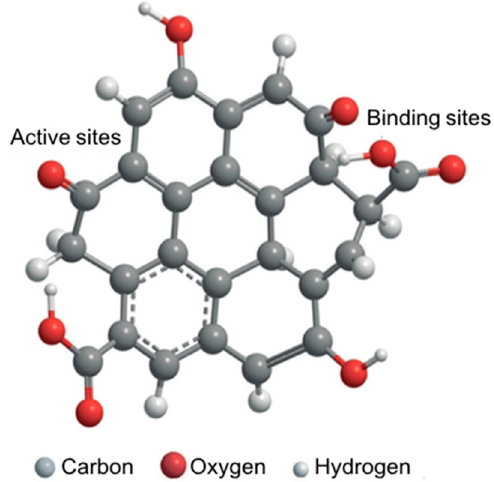
Figure 6. The catalytically active sites (for hydrogen peroxide) and binding sites (for the chromogenic substrate) of graphene oxide quantum dots which exhibit peroxidase-like activity. (Adapted with permission from [73]. Copyright © 2015 WILEY-VCH Verlag GmbH & Co. KGaA, Weinheim, Germany).